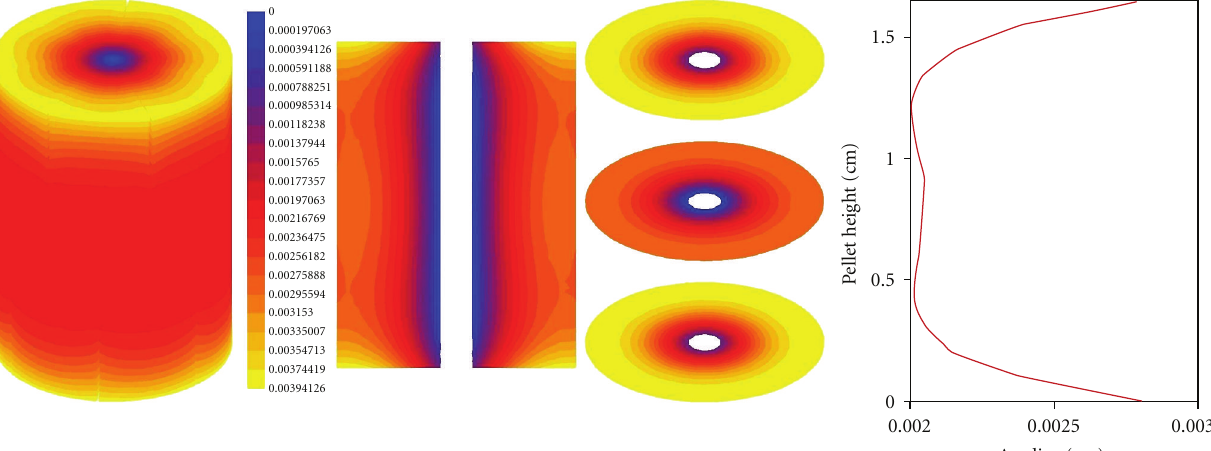
Figure 14: Radial deformation of a hollowed pellet from three di ff erent points of view and radial deformation.